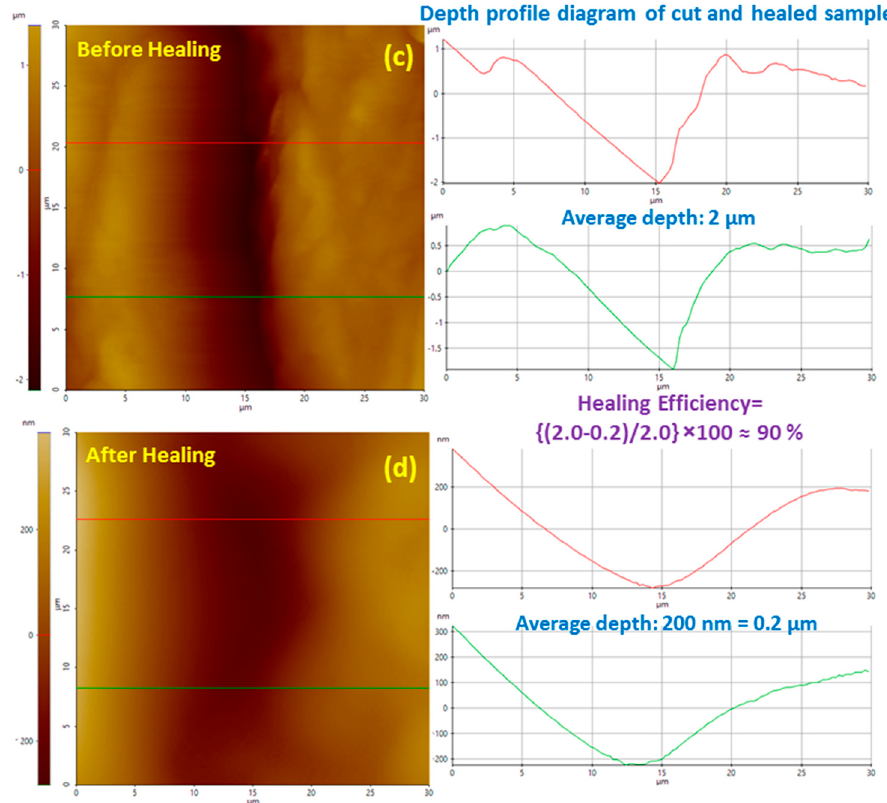
Figure 12. AFM images of cut sample ( a ) Height images of original cut and ( b ) healed sample at 120 °C for 10 h ( c ) 2D height images of original cut and ( d ) healed sample at 120 °C for 10 h.